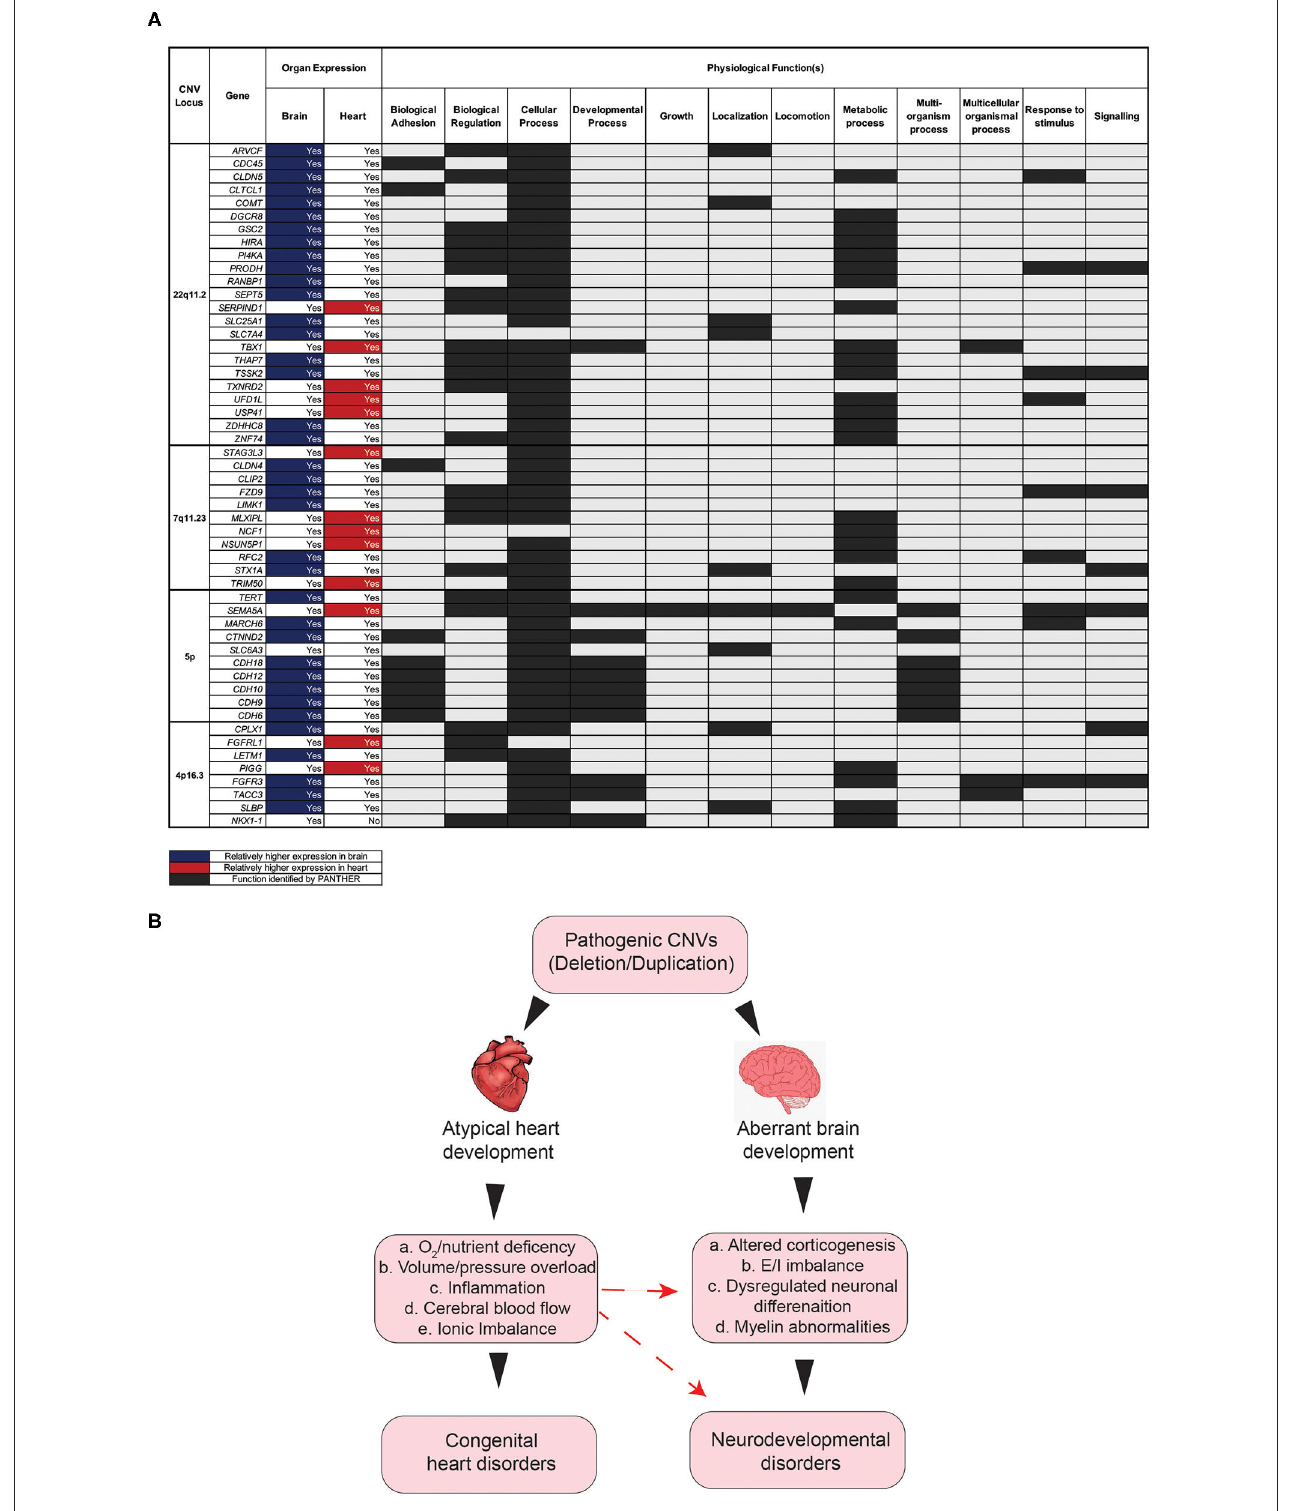
FIGURE 5 | Impact of gene disruption on the onset of aberrant brain and heart development. (A) Physiological functions of genes associated in the comorbidity of congenital and neurodevelopmental disorders of four CNVs with high CHD/NDD coincidence. (B) Schematic diagram showing the hypothesis as to how the CHD presence in CNV patients can contribute to NDD phenotypes secondarily. CNV, copy number variant; CHD, congenital heart disease; NDD, neurodevelopmental disorder.